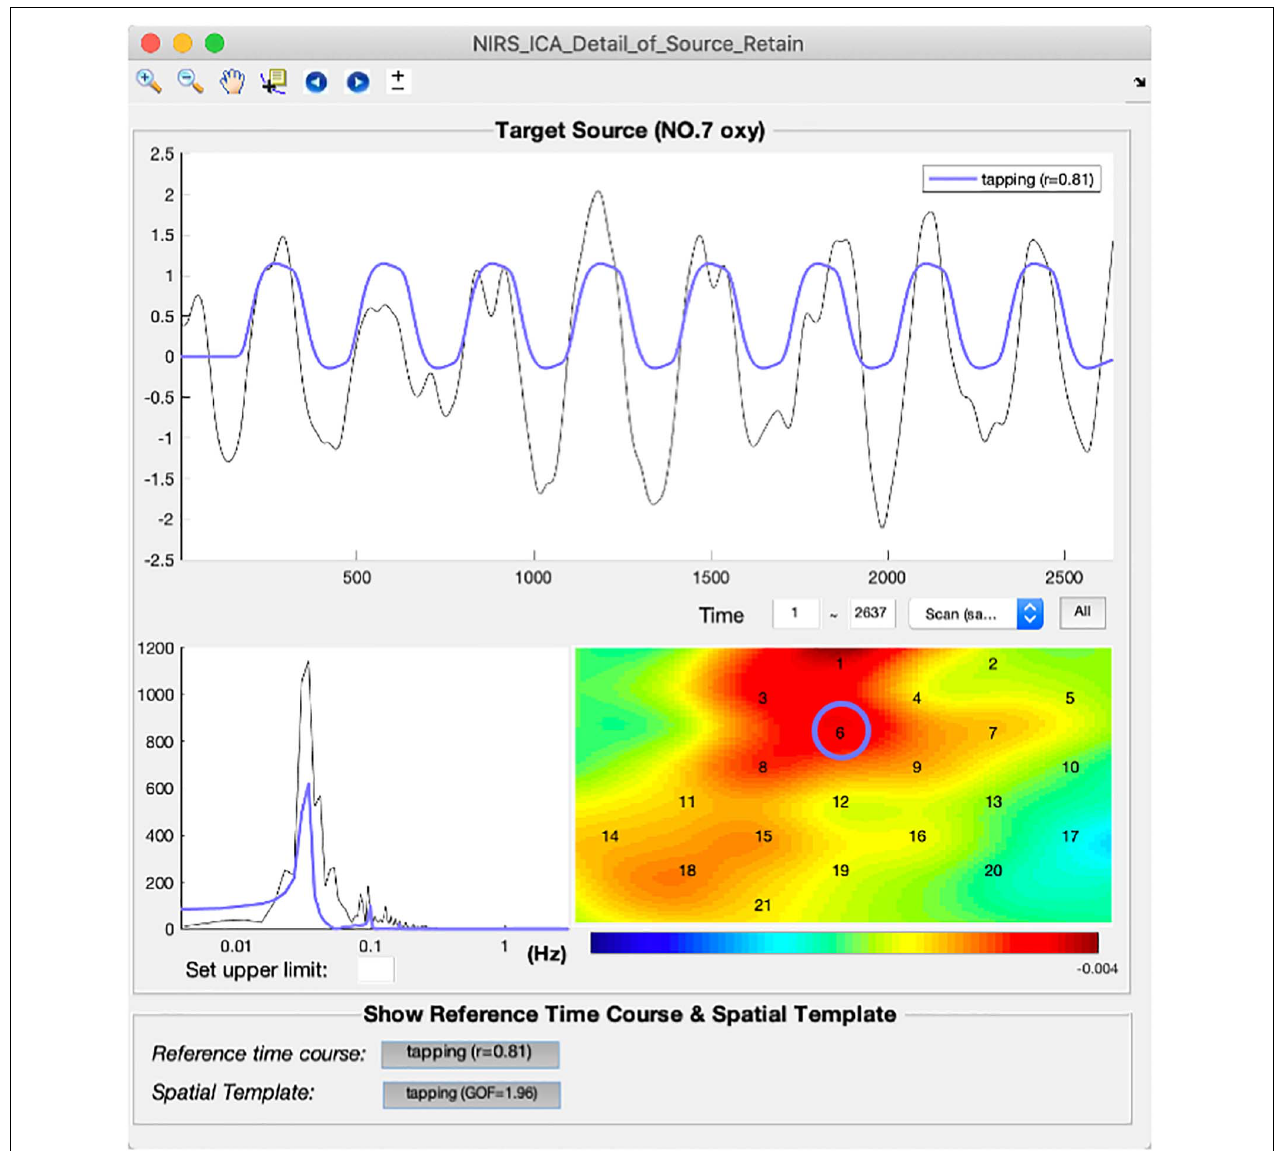
FIGURE 8 | The interface of detailed displaying for extracting sources of